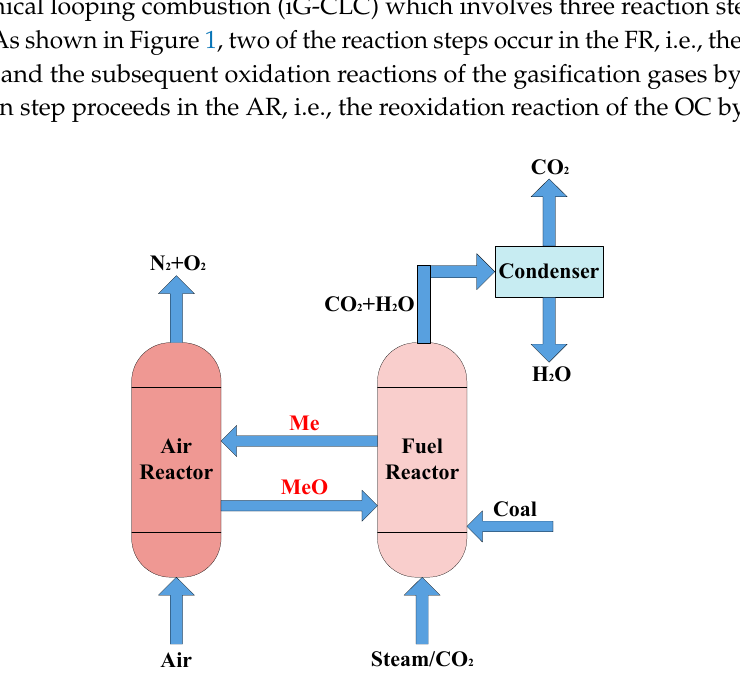
Figure 1. Schematic diagram of an in situ gasification chemical looping combustion (iG-CLC) system.